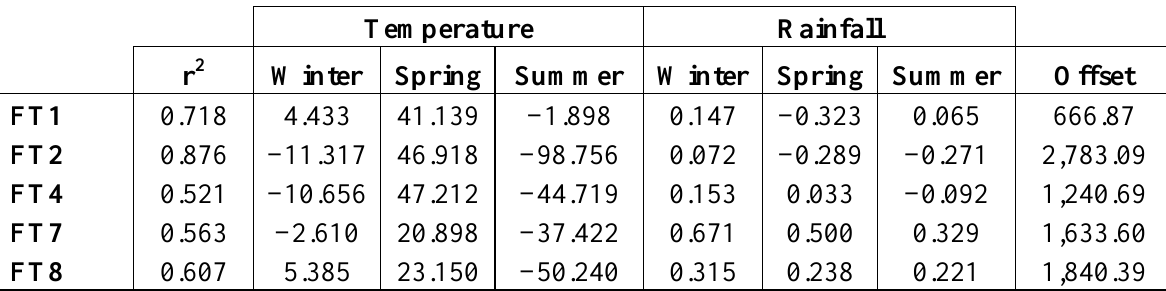
Table 3. Determination and regression coefficients and offsets of the multivariate linear models found for the five forest types examined. The models relate annual forest GPP (g C /m 2 /year) to seasonal temperature (°C) and rainfall (mm), with the exclusion of winter (see text for